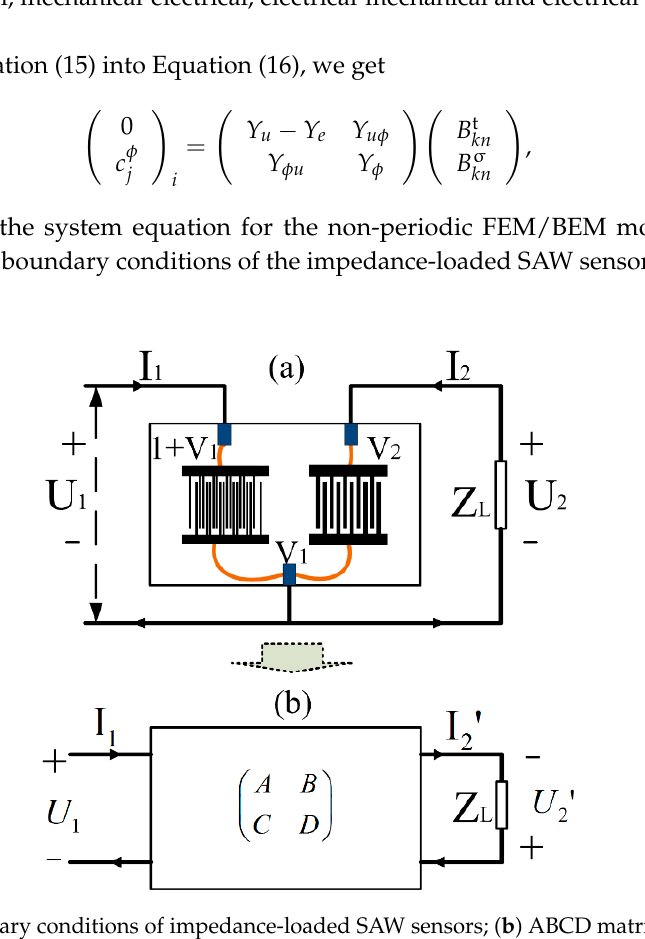
Figure 6. ( a ) Boundary conditions of impedance-loaded SAW sensors; ( b ) ABCD matrix representation of impedance-loaded SAW sensors.